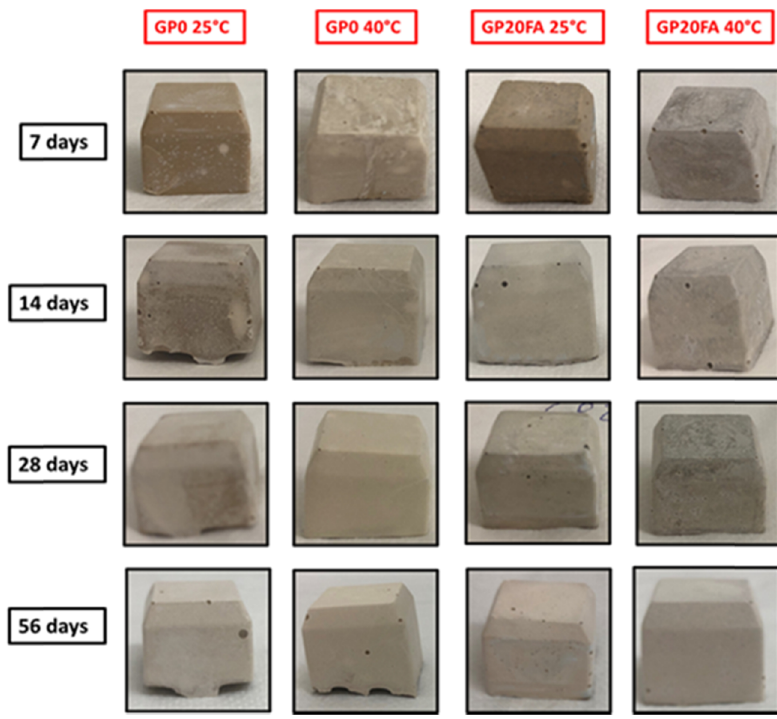
Figure 3: Images of the samples after extraction at di ff erent ageing